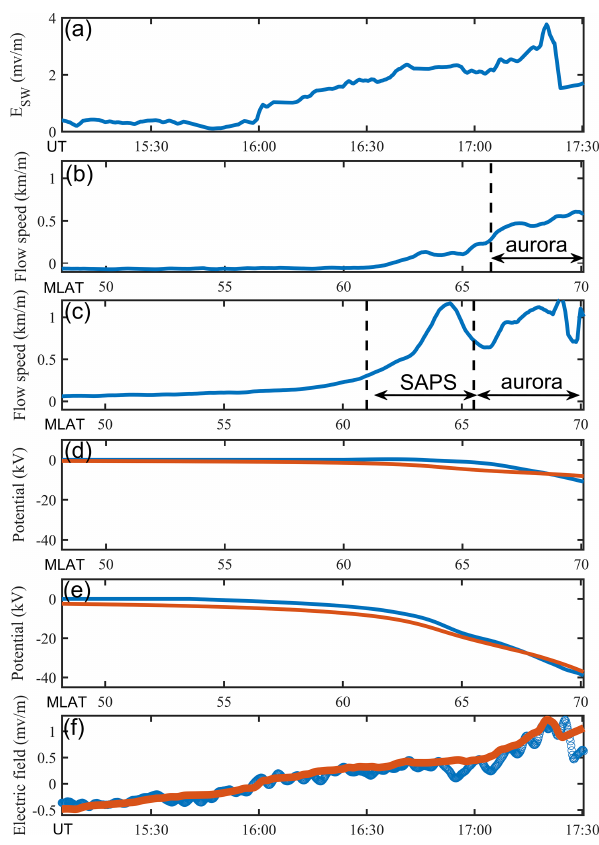
Figure 3. (a) The E SW data from OMNI but delayed by 5min. (b) The flow speed detected by DMSP F17 from 15:16 to 15:22UT at MLT ∼ 17.2h. (c) The flow speed detected by DMSP F17 from 16:58 to 17:03UT at MLT ∼ 17.5. The SAPS region is indicated by the two vertical dashed lines. (d) The DMSP-measured electric po- tential (blue curve) and the modeled electric potential (red curve) from 15:16 to 15:22UT. (e) The same as (d) but from 16:58 to 17:03UT. (f) The measured electric field in the dawn–dusk direc- tion by Van Allen Probe A (blue curve) and the modeled electric field along the trajectory of Van Allen Probe A (red